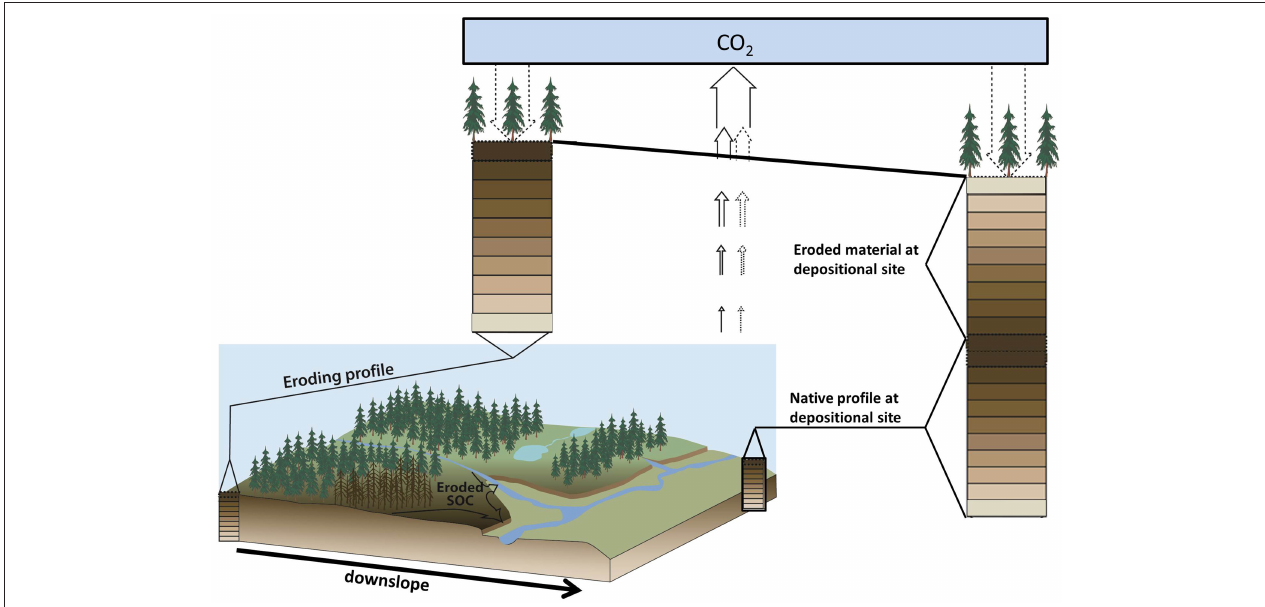
FIGURE 1 | Schematic of a landscape experiencing erosion (upslope) and deposition (downslope), as conceptualized by the Soil Organic C Erosion Replacement and Oxidation-Deposition (SOrCERODe) model. Shades of brown at each depth depict variation in SOC concentrations with depth. In the eroding profile and native profile at the depositional site, SOC concentrations decline with depth. In eroded material deposited at depositional site, colors are inverted to represent topsoil layers with relatively high SOC concentrations being deposited prior to formerly deep layers. Note that the coloring does not reflect new SOC production at the depositional setting. At both eroding and depositional sites, SOC production (dashed downward-facing arrows) occurs concurrently with SOC oxidation (solid, upward-facing arrows) and CO 2 production by autotrophs (dashed, upward-facing arrows). SOrCERODe allows the user to define the erosion rate, the deposition rate, and the degree to which SOC production and oxidation at each depth is influenced by erosion at the eroding site and by deposition at the depositional site. Figure adapted from Billings et al.